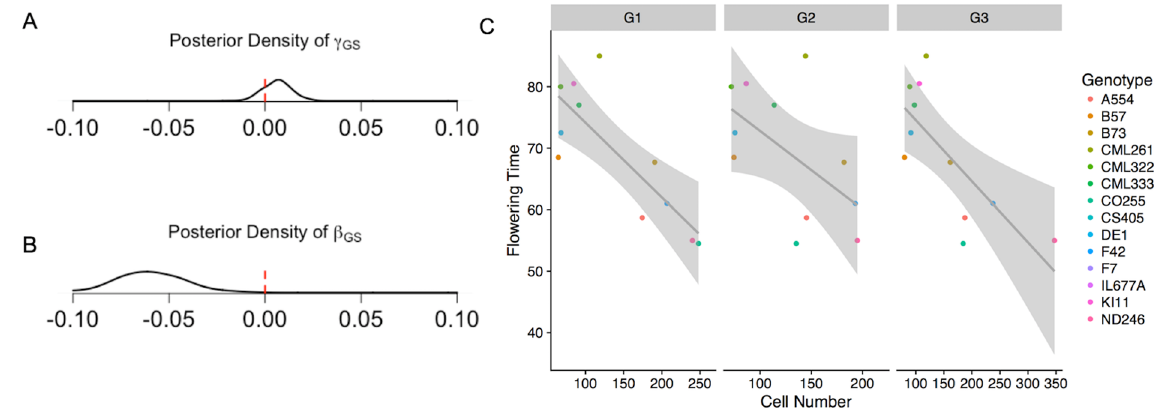
inbred maize accessions. Measurements for cell number are shown for each of three growth phases (G1, G2, G3). Data from Leiboff et al .